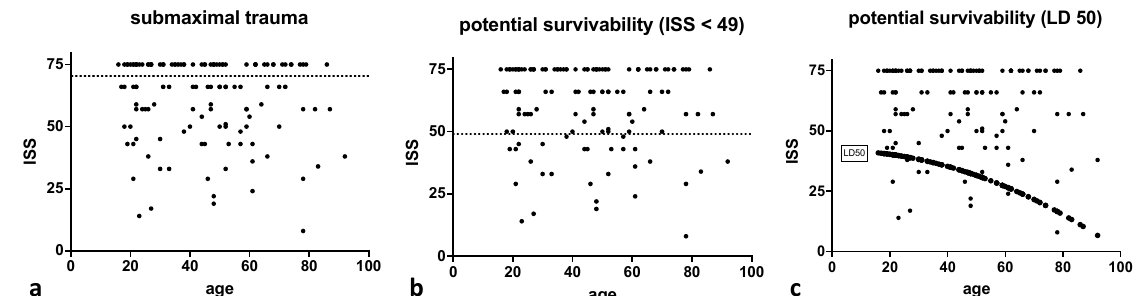
Figure 4. Age versus Injury Severity Score (ISS) for trauma victims with submaximal trauma/ISS < 75 ( a ), potentially survivable injuries/ISS < 49 ( b ), and age versus Injury Severity Score (ISS) and LD50 derived from Bull’s probit analysis ( c ). Submaximal trauma was present in 56% and potentially survivable trauma in 22% and 9%, respectively. Table 3. Absolute (relative) frequencies and comparison of demographic data, trauma mechanisms, and causes of death for trauma victims with submaximal trauma/ISS < 75, potentially survivable injuries/ISS < 49, and potentially survivable (ISS < LD50 as derived from Bull’s probit analysis). N (ISS < 75) = 73, n (ISS < 49) = 28, n (ISS < LD50) = 11.